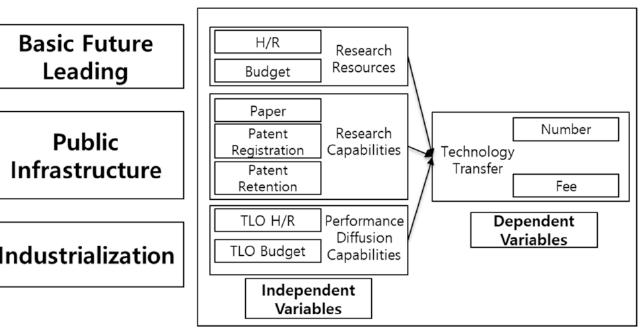
Figure 1. Research model for the factors affecting technology transfer by GRI mission